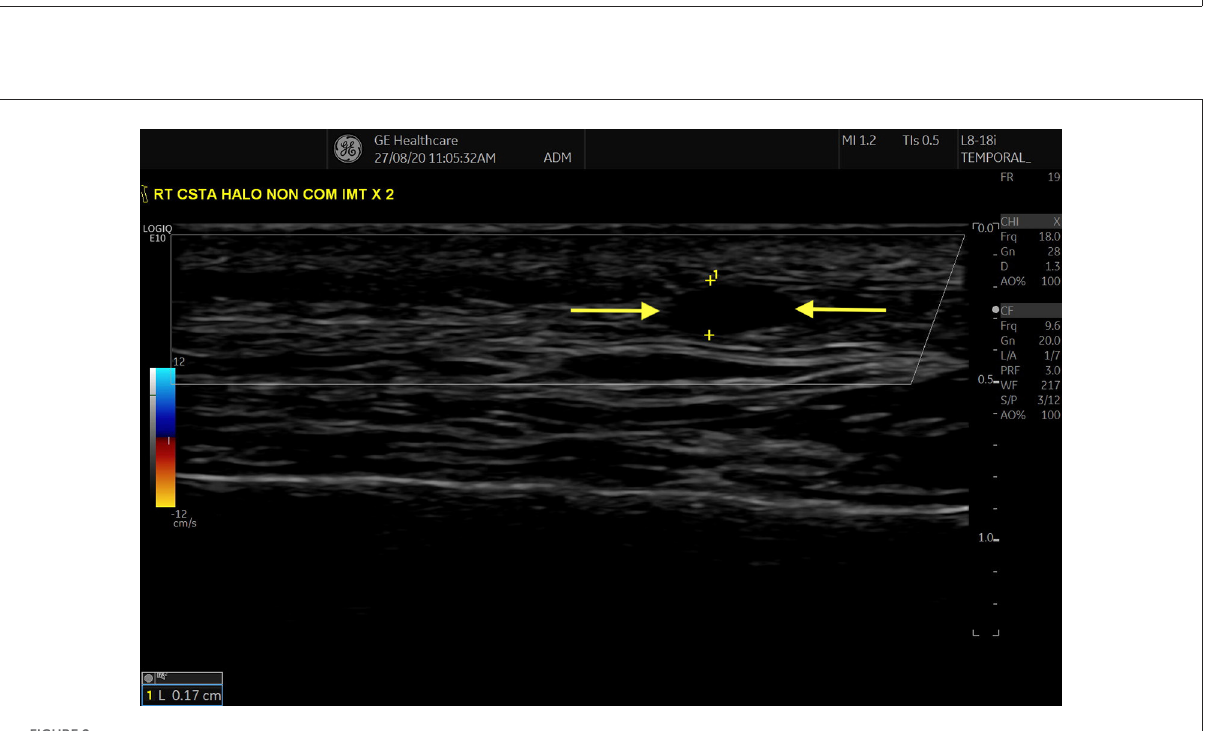
FIGURE2 “Compression” sign in STA, transverse view. Hypoechoic/ anechoic region between two parallel hyperechoic lines (adventitia) represents an oedematous Intima-Media Complex (region between two yellow